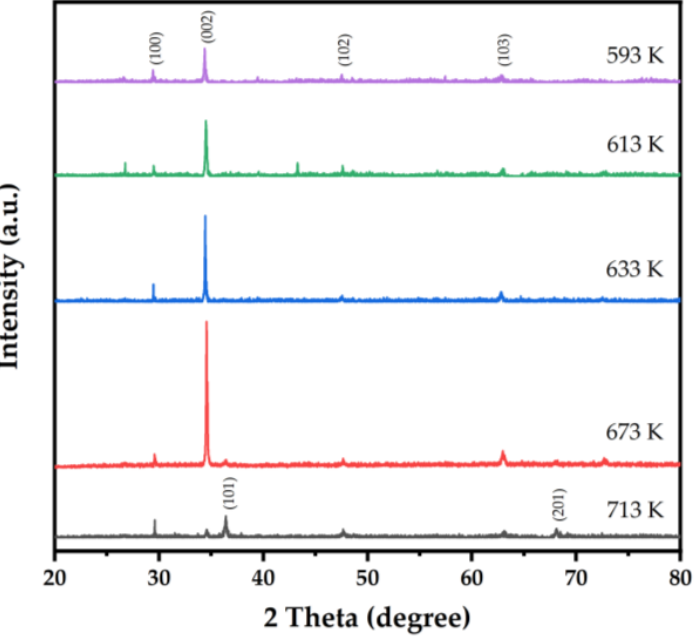
Figure 11. XRD patterns of ZnO thin films at the deposition temperature of 573 K; 613 K; 633K; 673K and 713 K.